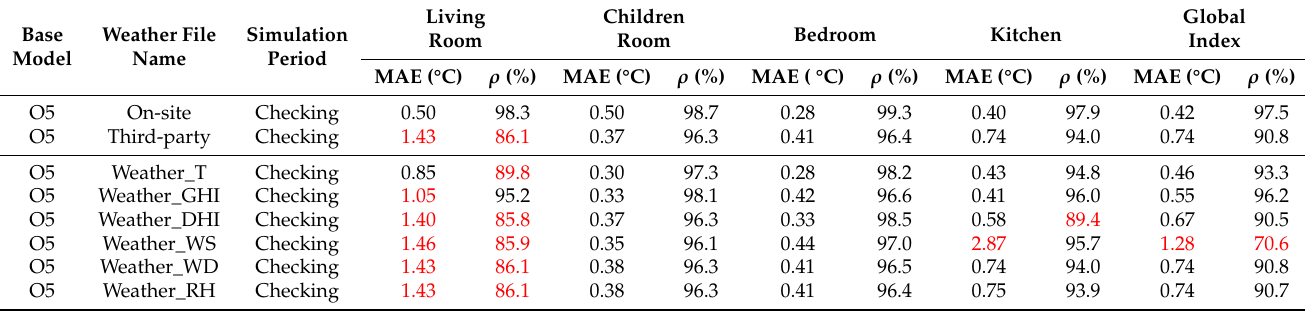
Table A8. MAE and ρ indices per thermal zone in the checking period. House O5, calibrated